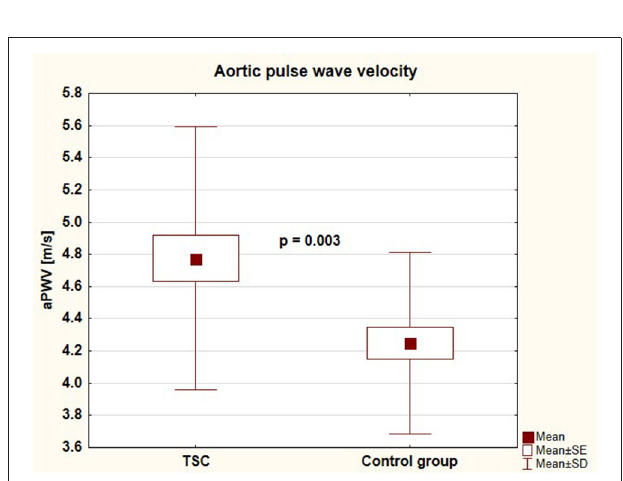
FIGURE 5 | Aortic pulse wave velocity in children with tuberous sclerosis complex and in control group (aPWV, aortic pulse wave velocity; TSC, tuberous sclerosis complex; SE, standard error; SD, standard deviation).